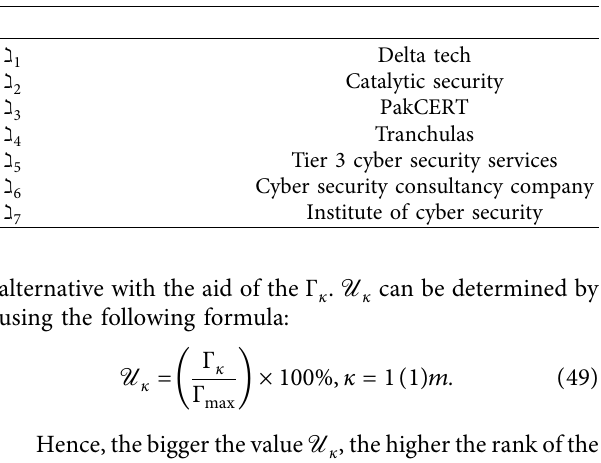
Table 1: Network security service providers